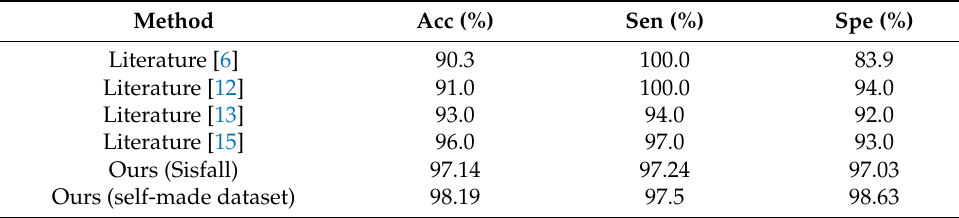
Table 9. Test results of different